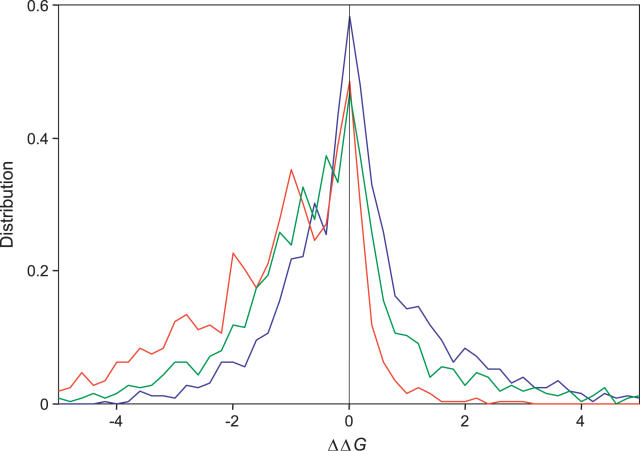
Distribution of Errors in Reconstruction Stabilities (ΔΔG) When Reconstructions Are Made with MP (Green), ML (Red), and BI (Blue)